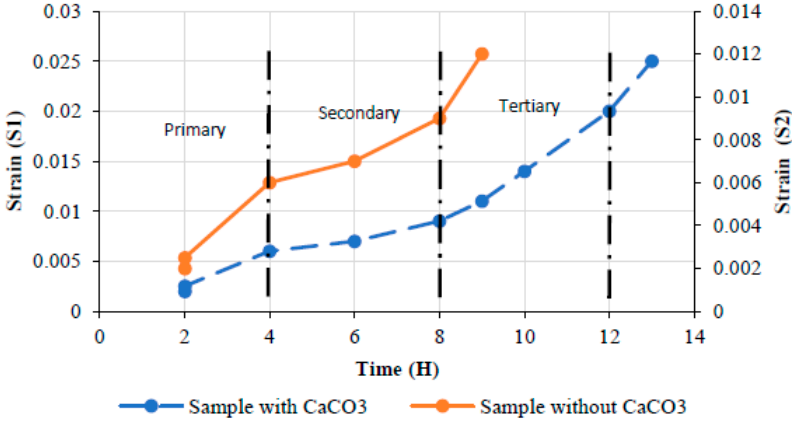
Figure 10. The influence of calcium carbonate as filler on creep properties of fiberglass composite [89].